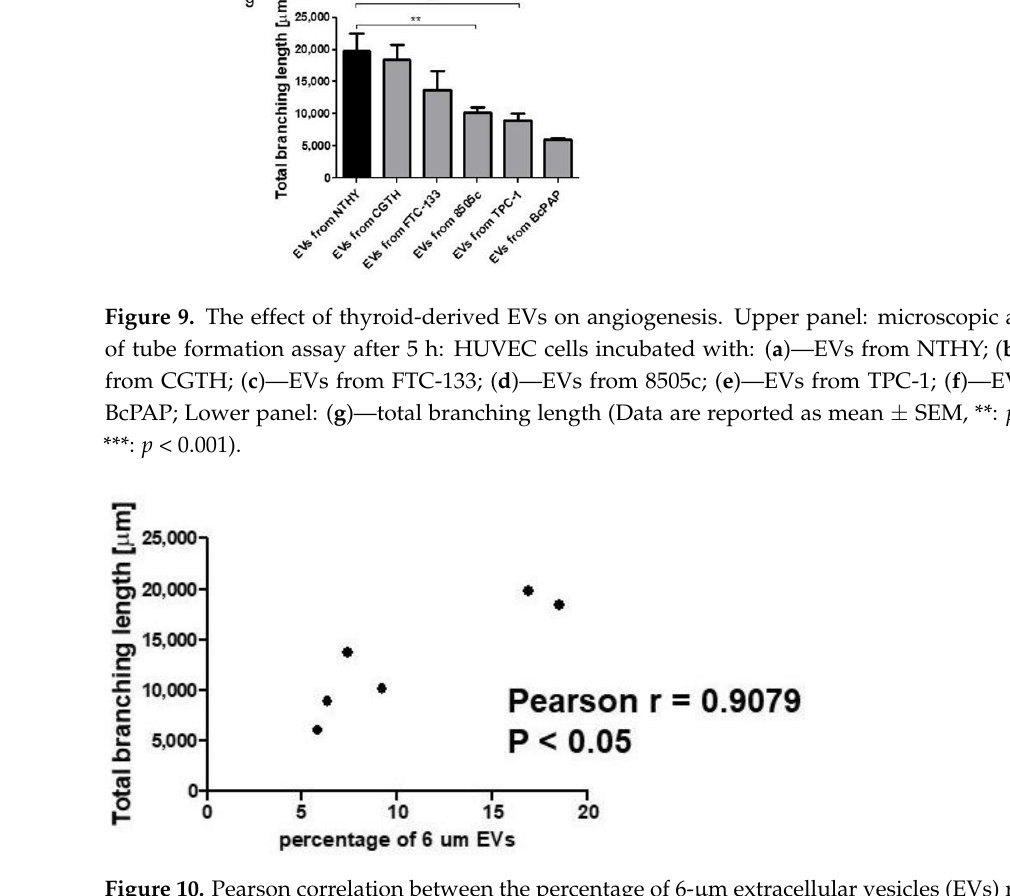
Figure 10. Pearson correlation between the percentage of 6-µm extracellular vesicles (EVs) released by cells and their pro-angiogenic potential.